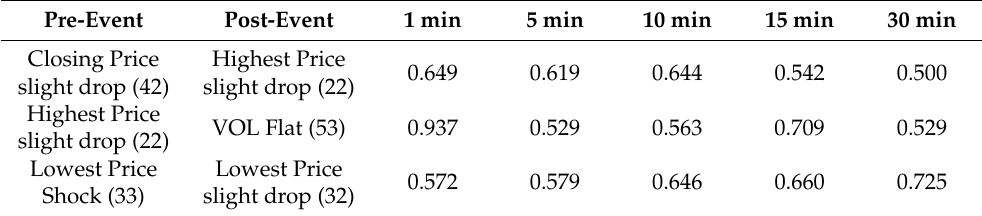
Table 3. Comparison of support for association rules at different temporal granularity of Lanzi.